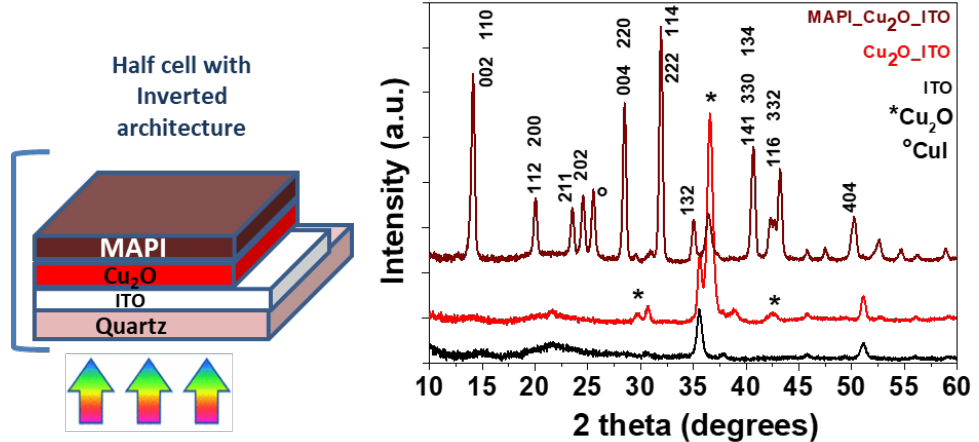
Figure 7. X-ray diffraction patterns of ITO substrate (black line), Cu 2 O thin film prepared by MOCVD on the ITO substrate at 250 °C (red line) and the multilayer system MAPI/Cu 2 O/ITO substrate (brown line). The * indicates the Cu 2 O peaks. On the left, a cartoon is shown of the planar inverted architecture realized up to the MAPI deposition.